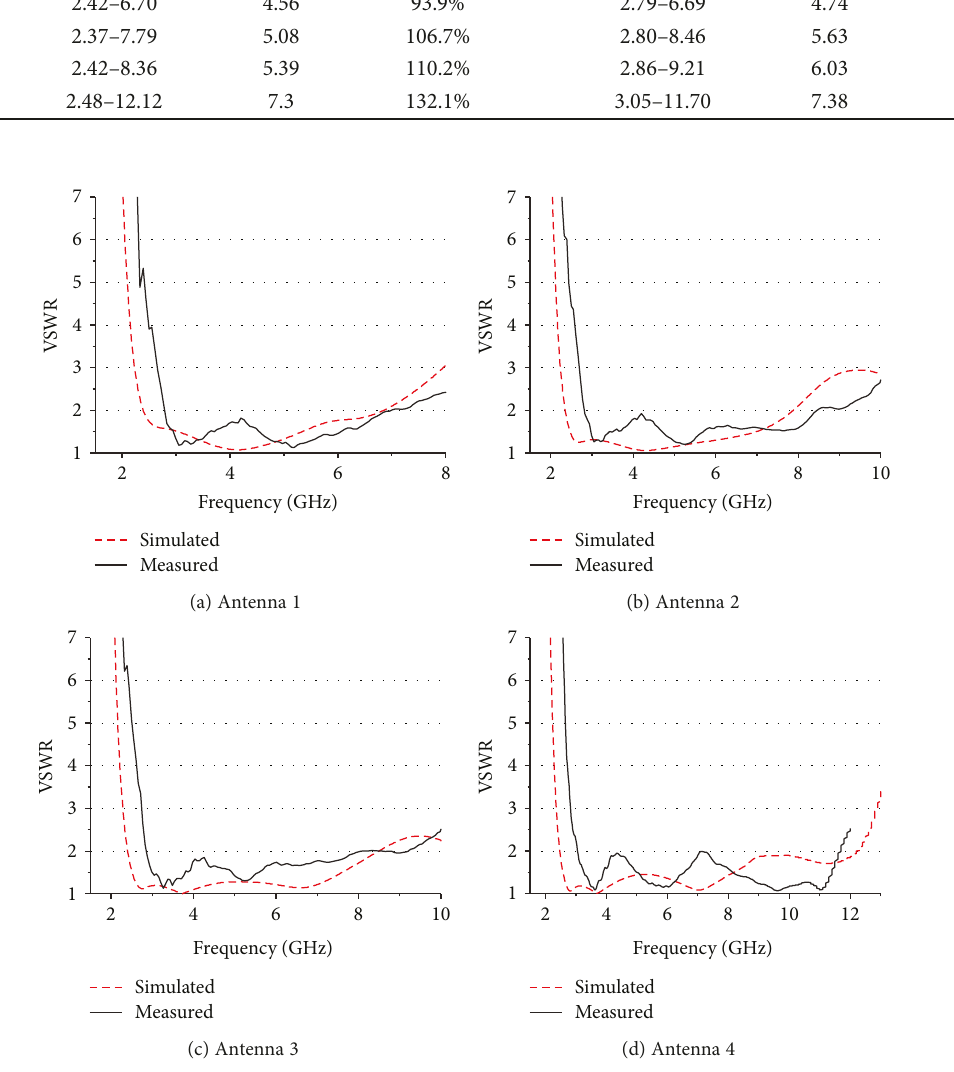
Figure 10: Simulated and measured